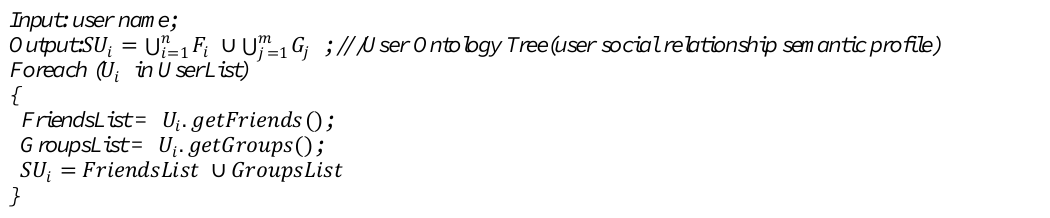
Algorithm2: Construct User Social Relationship Semantic